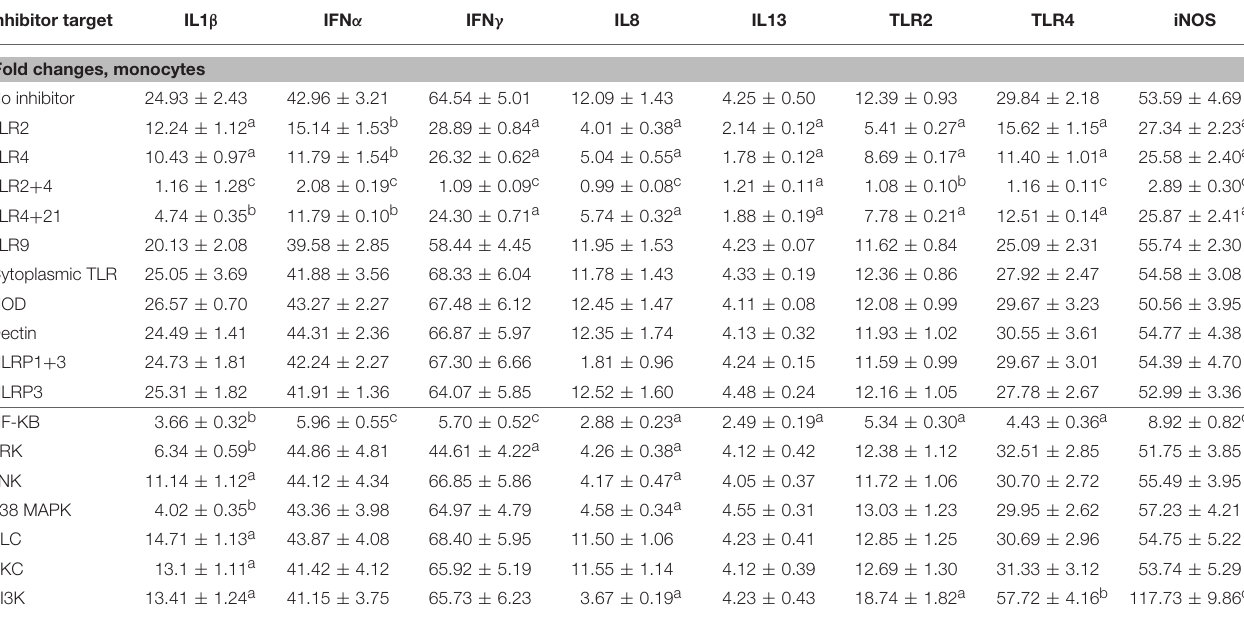
TABLE 7 | Transcription in monocytes relies on TLR2 and TLR4 activation and requires intra-cellular mediators that differ according to the genes. Inhibitor